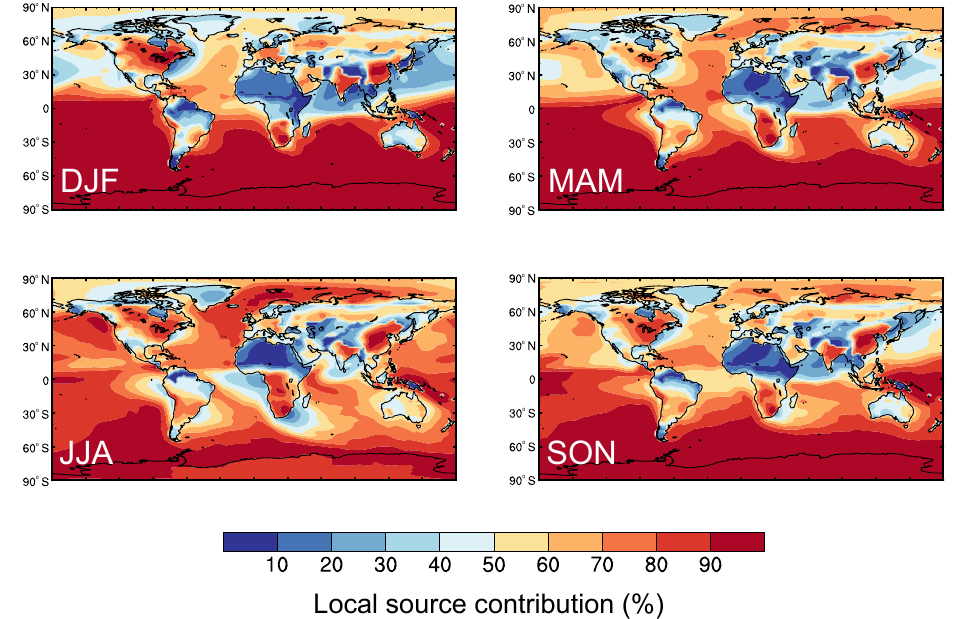
Figure 5. Relative contributions (%) of local emissions (inside the tagged regions) to near-surface sulfate concentrations. Contributions from natural source sectors are added to ROW here. Contributions less than 50% are shown in cold colors and those larger than 50% are shown in warm